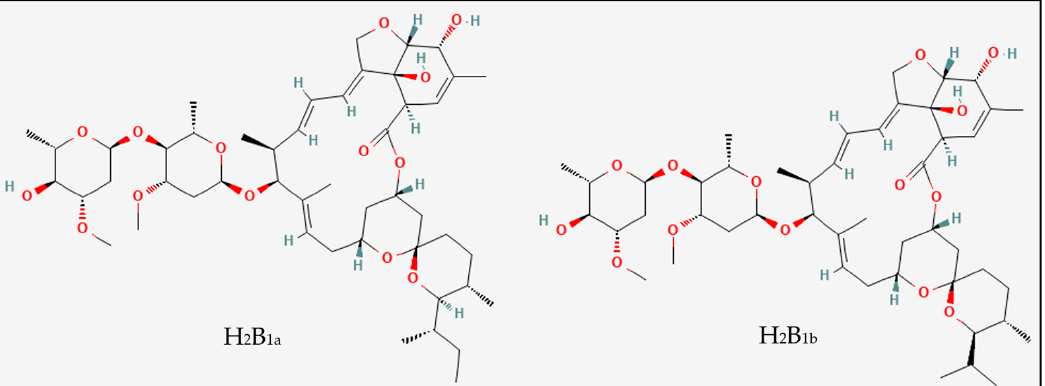
Figure 1. Chemical structure of Ivermectin (IVM), consisting of components H 2 B 1a (C 48 H 74 O 14 , 875.1 g/mol) and H 2 B 1b (C 47 H 72 O 14 , 861.1 g/mol). Figure adapted from references [18,19] .